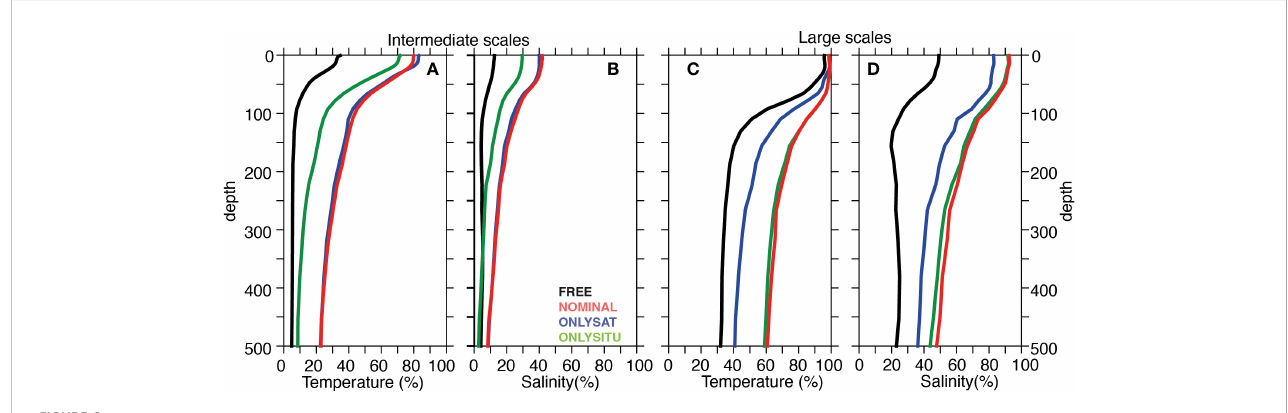
FIGURE 6 Globally averaged percentage of Nature Run represented variance for subsurface temperature and salinity at intermediate (A, B) and large scales (C, D) from the FREE, NOMINAL, ONLYSAT, ONLYSITU experiments. Timeseries have been fi ltered with running mean fi lters (1°x1°x20-day, 9°x9°x90-day) as explained in the